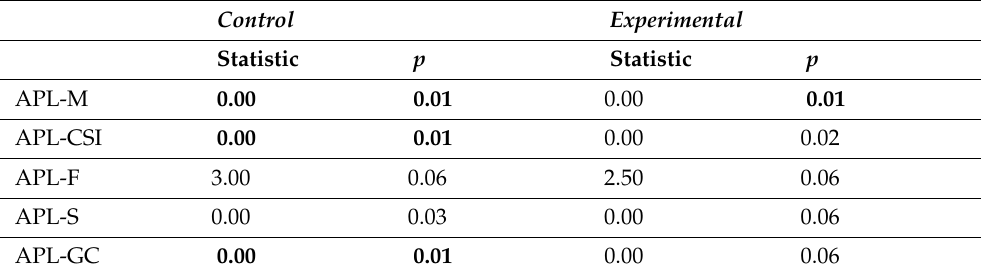
Table 6. Paired t -test analysis between T0 and T1 values in the two groups.